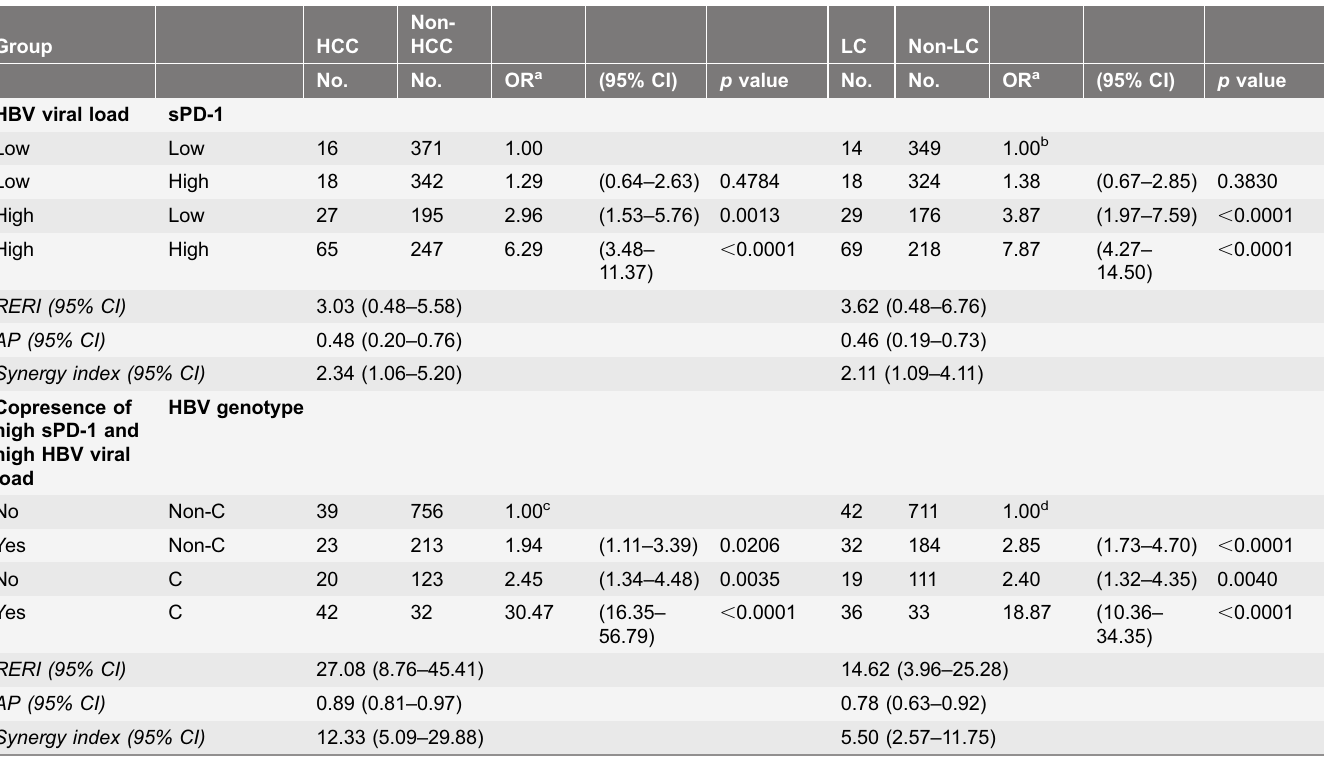
Table 3. Interactions of high sPD-1 with high HBV viral load and copresence of these two risk factors with genotype C HBV in risks for HCC and liver cirrhosis.